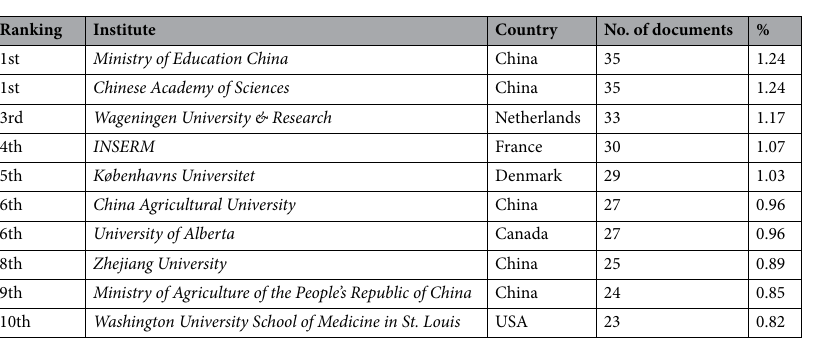
Table 2. Top ten active institutions in research related to the links between the microbiota and antibiotics from 2002 to 2021.